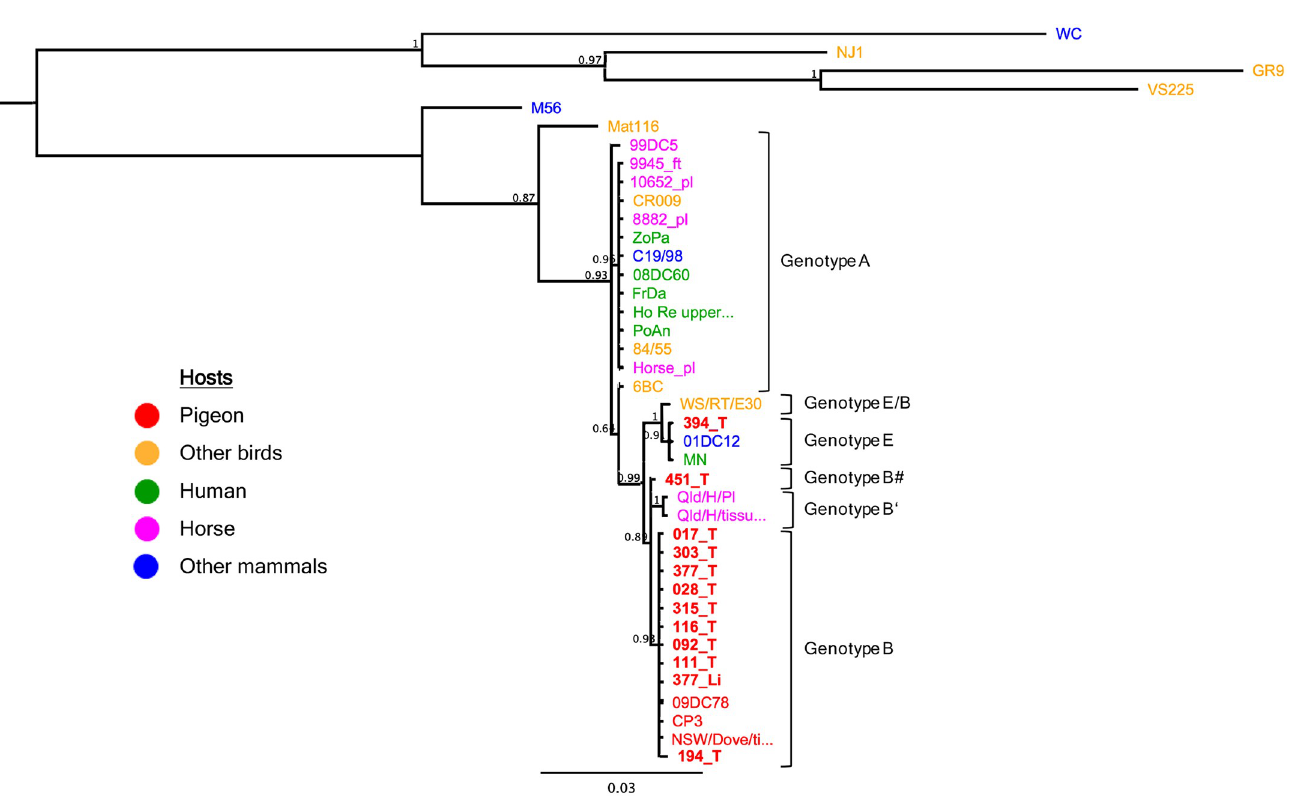
Fig 3. Bayesian phylogenetic tree of omp A gene sequences from 40 Chlamydia psittaci strains from avian and mammalian hosts. The host is color-labeled as depicted in the legend. M56 taxa was used as an outgroup. Samples from this study are marked in bold letters. The posterior probability values are displayed on the tree nodes.